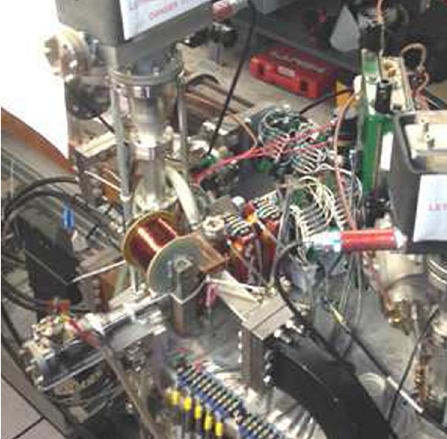
FIG. 7. Photograph showing the updated version of the micro- wave thermionic electron gun now operated as the injector for the 40 MeV linac presently used for our FEL and electron beam research at the University of Hawai ’